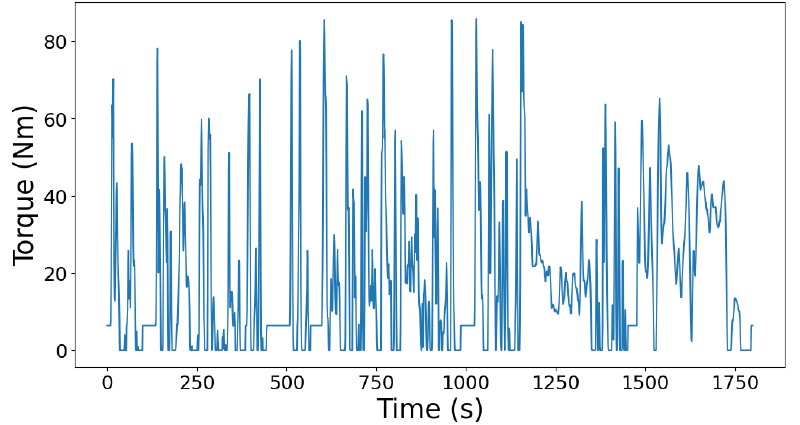
Figure 3. Motor torque over the WLTP drive cycle.